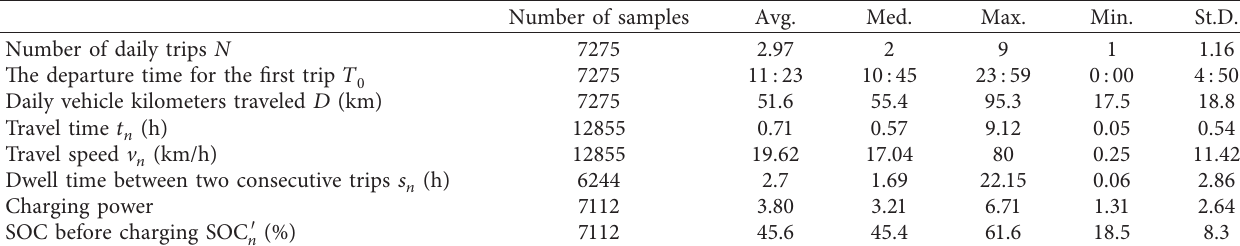
Table 2: Summary metrics of valid trips and charges.